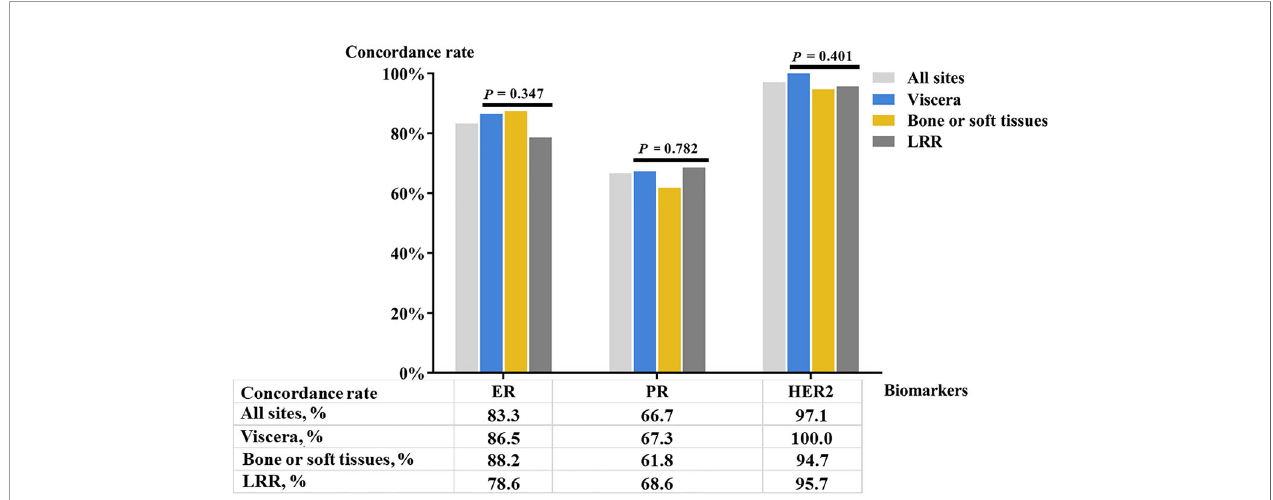
FIGURE 1 | Concordance rate of molecular biomarker status in different recurrent sites. LRR, loco-regional